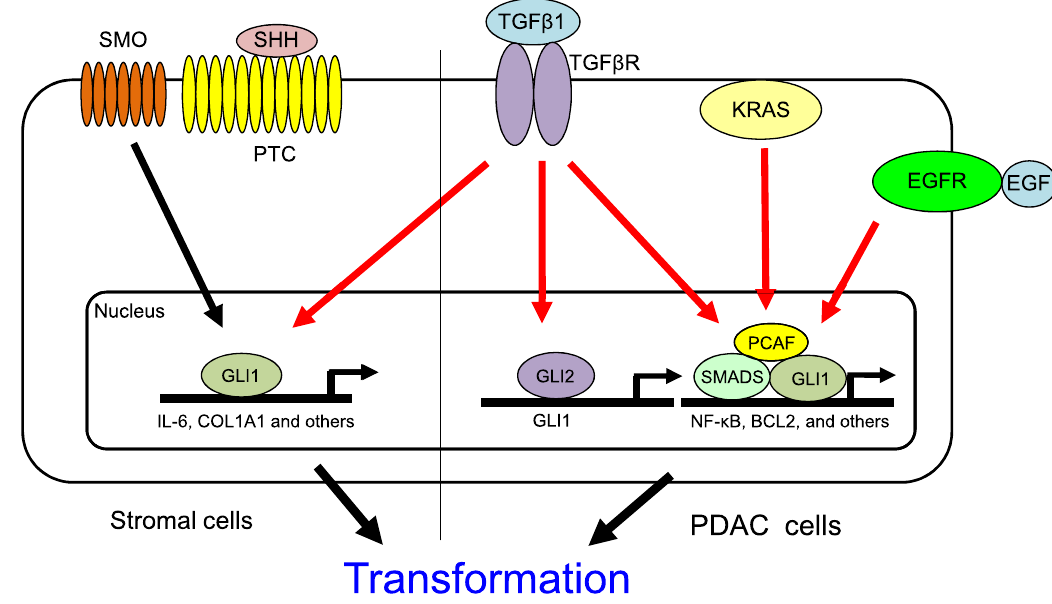
Figure 1. Schematic Representation of Pathways Modulating GLI1-expression/activity in Cancer. In canonical HH signaling in stromal cells, binding of the SHH ligand to Patched (PTC) activates the Smoothened (SMO) receptor, which induces GLI1 activation of its target genes, including IL-6 and COL1A1 (Martin E Fernandez-Zapico unpublished observation), leading to pre-malignant lesions. SMO-independent mechanisms for regulation of GLI1 in PDAC include KRAS, TGF β , and EGFR. GLI1 has been shown to regulate the NF- κ B pathway in a HH-independent manner downstream of KRAS, leading to pancreatic epithelial transformation. TGF β promotes GLI2 expression in PDAC through Smad3 and β -catenin/LEF-TCF-dependent upregulation of GLI2 independent of HH signaling. TGF β induced GLI2 expression, and subsequent GLI1 activation, is associated with EMT, tumor growth, and metastasis. TGF β can also modulate GLI1 activity by promoting the formation of a transcriptional complex with the TGF β -regulated transcription factors, SMAD2 and 4, and PCAF, at the BCL2 promoter in cancer cells to regulate TGF β -induced gene expression. EGFR signaling is aberrantly activated in a majority of PDACs. EGFR and HH have been demonstrated to act synergistically to promote cancer cell initiation and growth by modulation of gene expression of distinct novel pathways through a GLI1-dependent